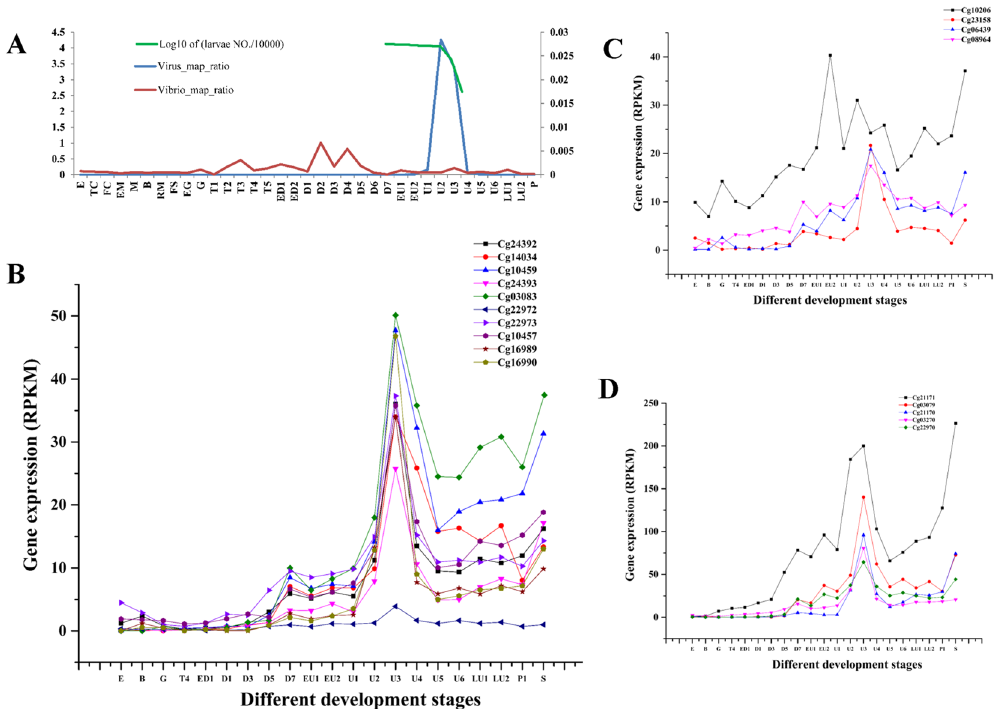
Figure 1. Response of oyster larvae to OsHV-1 infection. ( A ) Ratio of RNA-seq reads mapping to the OsHV-1 and Vibrio genomes; the number of oyster larvae is also shown. Sampling times of oyster larvae and abbreviations for developmental stages are the same as those in Table S12 of ref. 31. The abbreviations are: E: Egg; TC: Two cells; FC: Four cells; EM: Early morula; M: Morula; B: Blastula; RM: Rotary movement; FS: Free swimming; EG: Early gastrula; G: Gastrula; T: Trochophore; ED: Early D-shape larvae; D: D-shape larvae; EU: Early umbo larva; U: Umbo larva; LU: Later umbo larva; P: Pediveliger. S: Spat. ( B ) Expression of RIG-I like receptors (RLRs) in oyster larvae infected with OsHV-1. Cg24392 , Cg14034 , Cg22973 , and Cg03083 are RLRs with CARD domains, and the remaining genes do not possess CARD domains. ( C and D ) Expression of genes involved in the RLR signalling pathway, including TRAF2 ( Cg08964 ), TRAF3 ( Cg23158 ), TRAF6 ( Cg10206 ), three MITA (transmembrane protein 173) genes ( Cg06439 , Cg03079 , and Cg22970 ), and three IRF